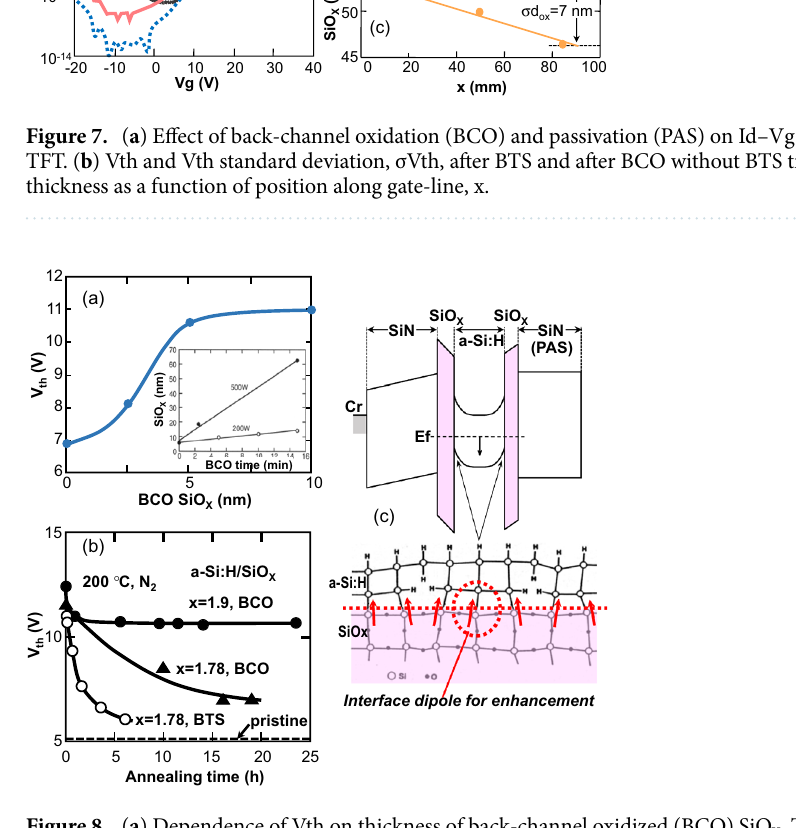
Figure 8. ( a ) Dependence of Vth on thickness of back-channel oxidized (BCO) SiO X . The inset shows the SiOx thickness dependence on the BCO process time for RF powers of 200 W and 500 W. ( b ) Stability of Vth as a function of annealing time for three different TFTs with gate SiOx stoichiometry, x = 1.78 and bias temperature stress (BTS), x = 1.78 and BCO, and x = 1.9 and BCO. The temperature of annealing in the N 2 atmosphere was 200 °C. ( c ) Band diagram of back-channel oxidized MNOS TFT. The red arrows show the electric dipoles at the SiO X /a-Si:H and a-Si:H/BCO SiO X